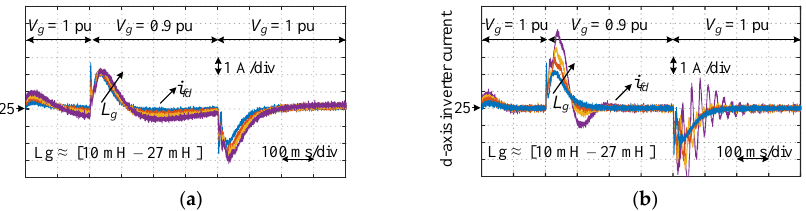
Figure 12. Time-domain simulations showing the system response for 10% voltage sag at grid under grid inductance uncertainties ( P = P n ), ( a ) f PLL = 1 Hz; ( b ) f PLL =12 Hz.